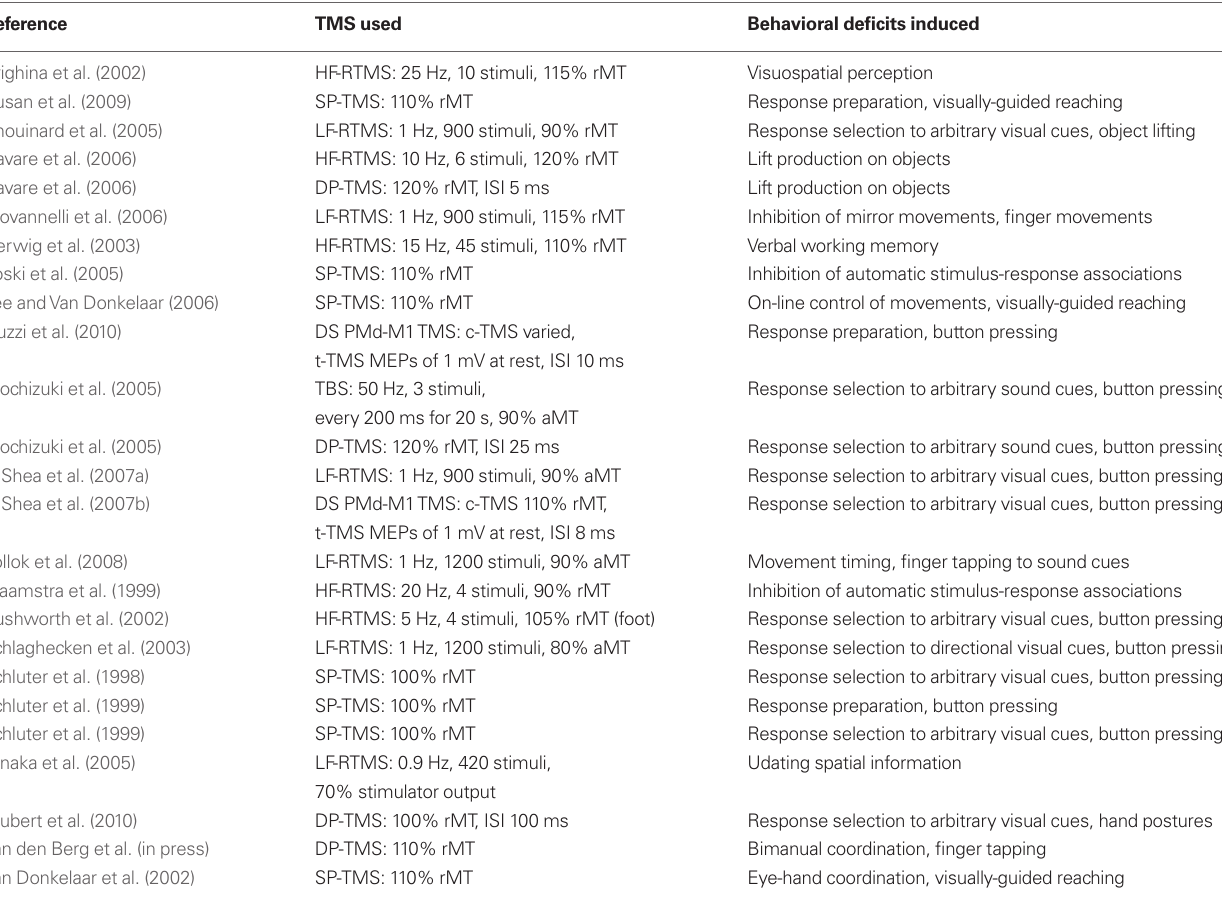
Table 1 | TMS studies of